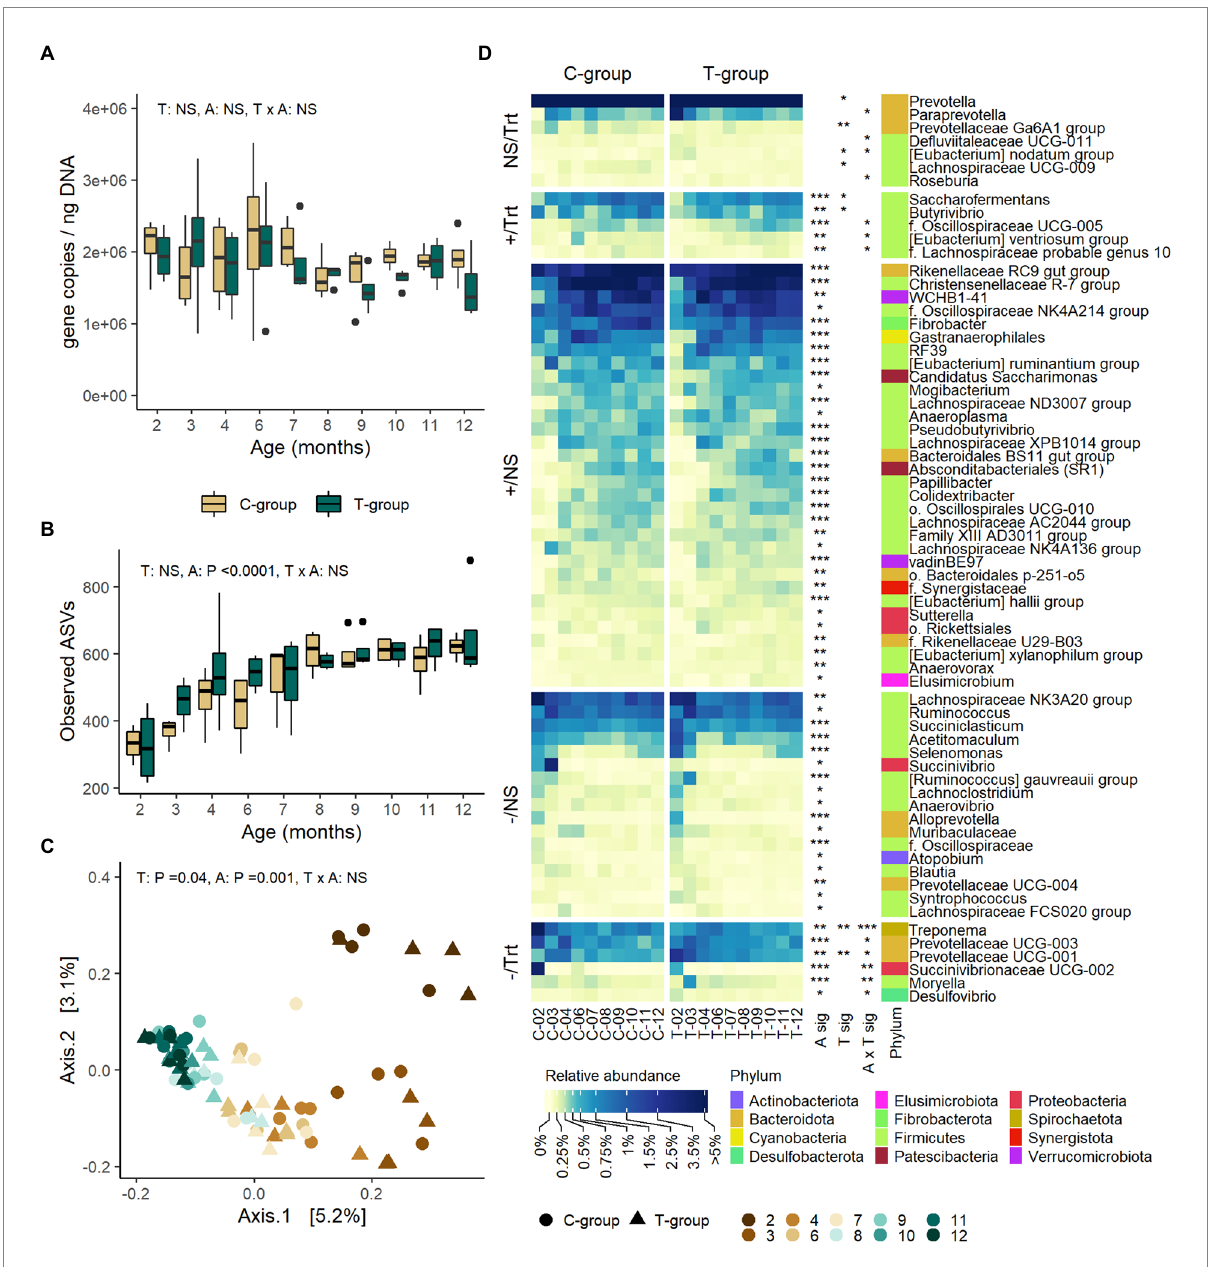
FIGURE 2 The rumen bacterial community in treatment (T-group) and control (C-group) heifers at 2–12 months of age. (A) The rumen bacteria 16S rRNA gene copy numbers, (B) the number of observed ASVs, (C) principal coordinate analysis visualization of Bray-Curtis community distances, and (D) the relative abundances of rumen bacterial genera with abundance >0.1%. Only taxa with statistical significances are shown. The taxa are grouped by increasing (+) or decreasing ( − ) trend with time, and with significant treatment effects (Trt) or no treatment effects (NS). Statistical significance of Treatment (T-sig), Age (A-sig) and Treatment × Age interaction (T × A sig): p < 0.05: *, p < 0.01: **, p < 0.001: